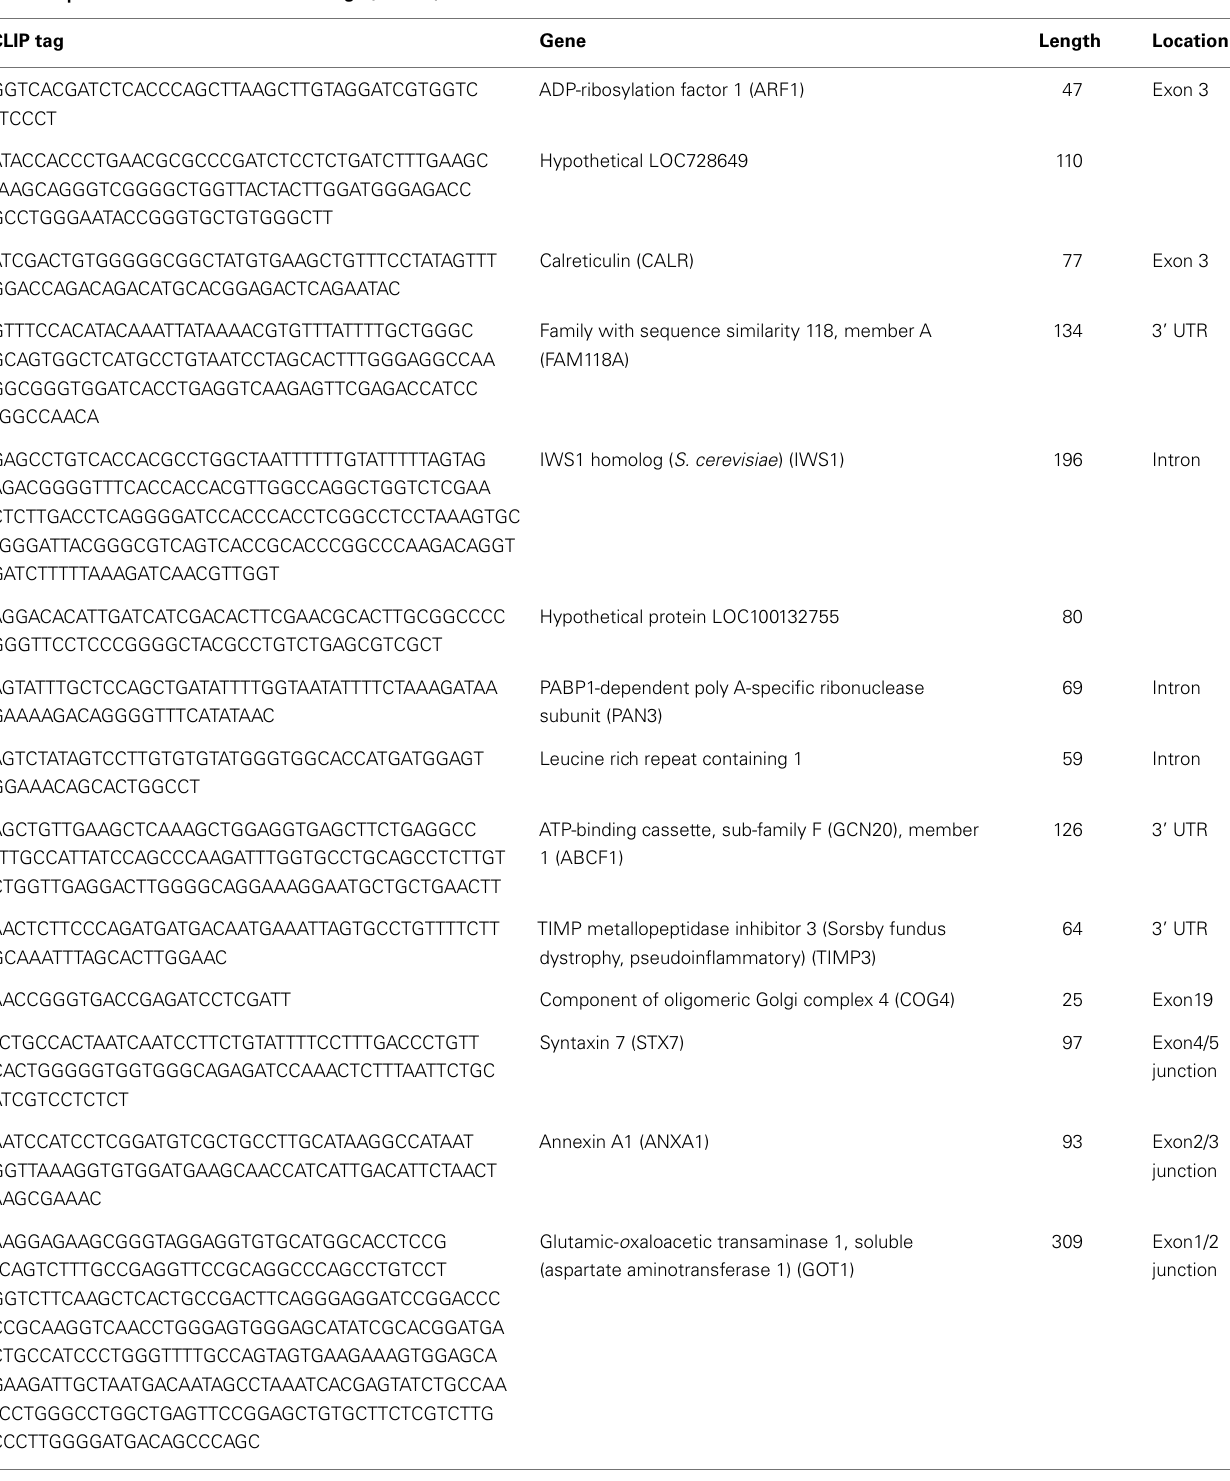
TableA1 |Annotated list of IRS-1 CLIP tags